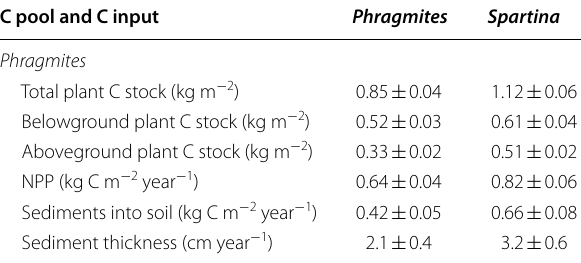
Table 2 Variation in the total C pools in the plants and C input by NPP calculated using data collected in September 2010 ( n 24, belowground biomass to a depth of 20 =